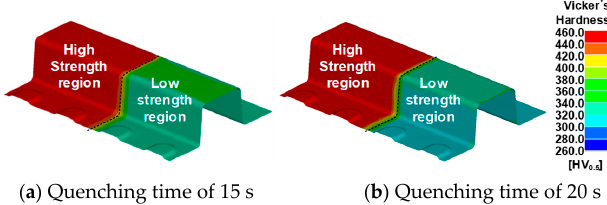
Figure 7. Predicted hardness distribution of partially quenched part for various quenching times at heated tool temperature of 400 °C.